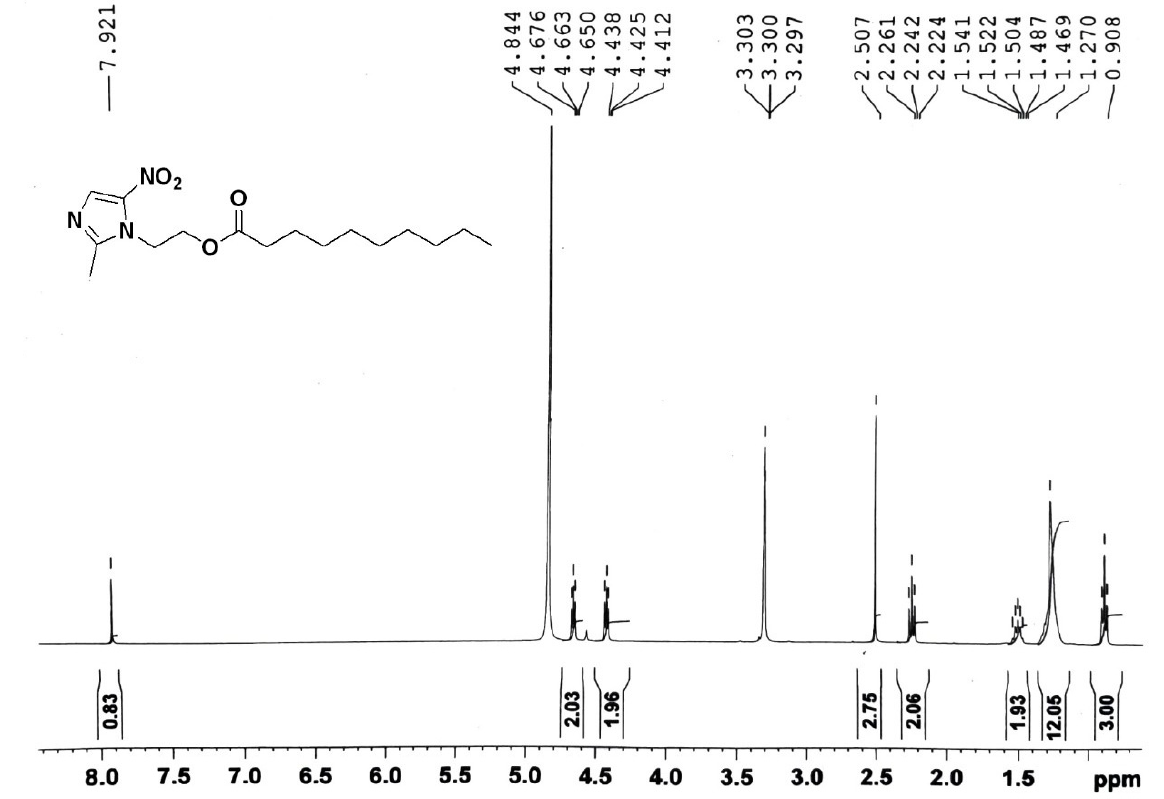
Figure 2. 1 H-NMR spectra of “ DC-Met-10”.